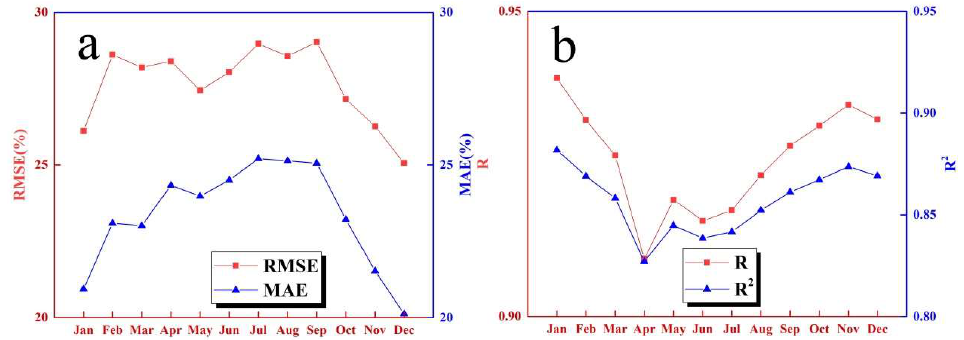
Figure 11. Monthly variation of the statistical indicators representing the accuracy of the YHM algorithm at the CMA radiation stations during 2002–2014 ( a for CARSNET stations, b for AERONET